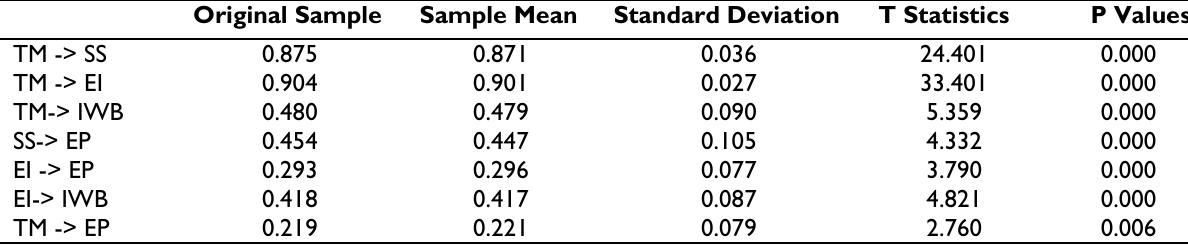
Table 4. Results of Research Hypothesis Test (Path Coefficients)